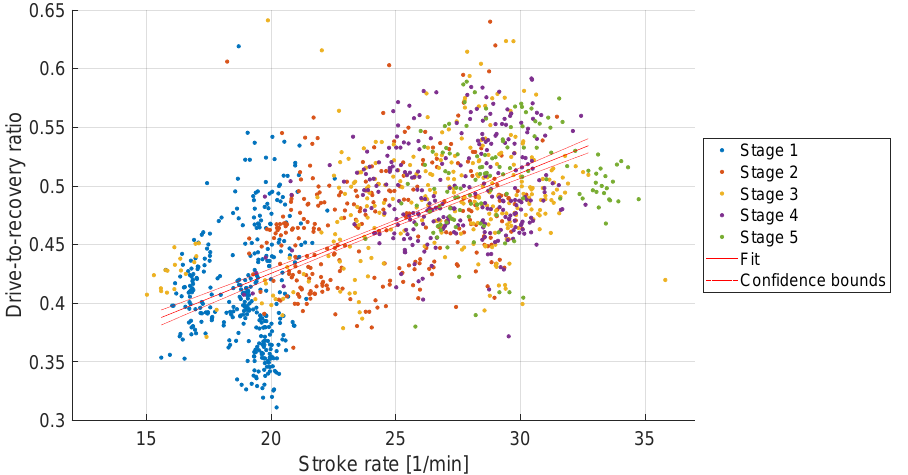
Figure 8. Drive-to-recovery ratio compared to the stroke rate during five stage rowing training. A linear regression fit and 95% confidence interval is marked in red.